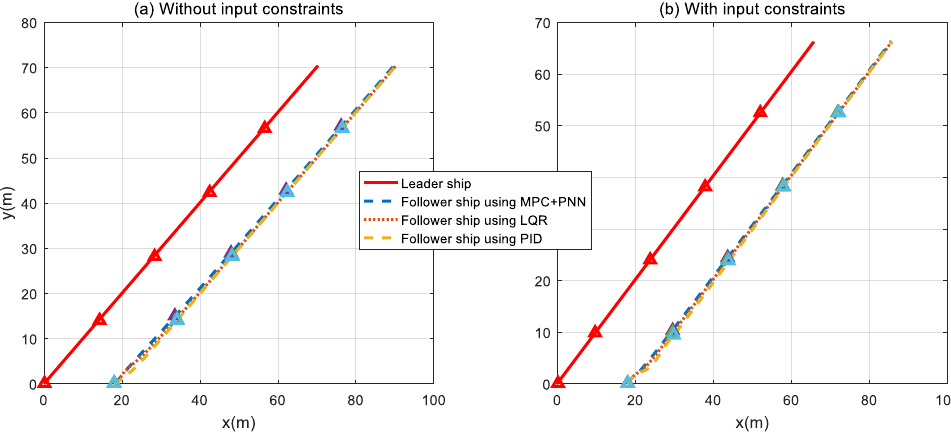
Figure 8. Comparative performance with and without input constraints.